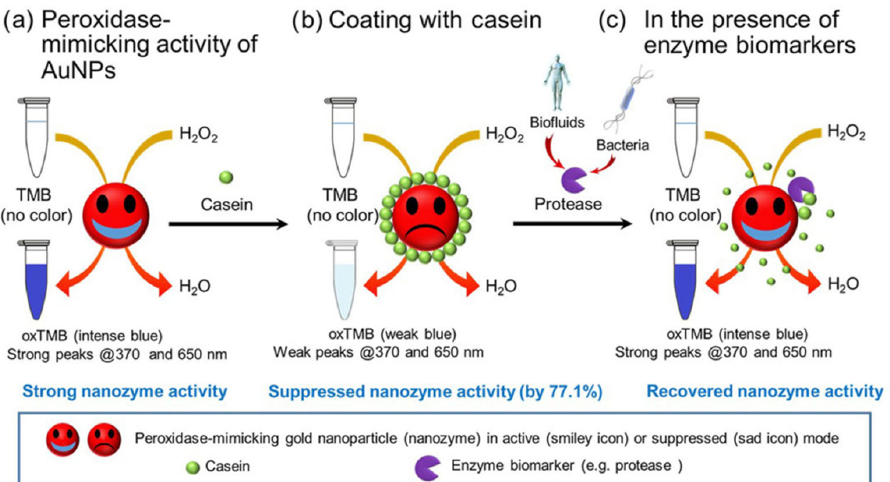
Figure 19. Strategy for the determination of proteolytic biomarkers using the β‐ Cas@Au nanozyme, based on the partial inhibition of nanozyme activity in the presence of the proteolytic biomarkers. ( a ) Peroxidase ‐ like activity of AuNP; ( b ) Nanozymatic activity inhibition because of casein coating; ( c ) Partial recovery of peroxidase ‐ mimicking activity in the presence of proteolytic biomarkers. Reprinted with permission from [64]. Copyright © 2018 Springer.